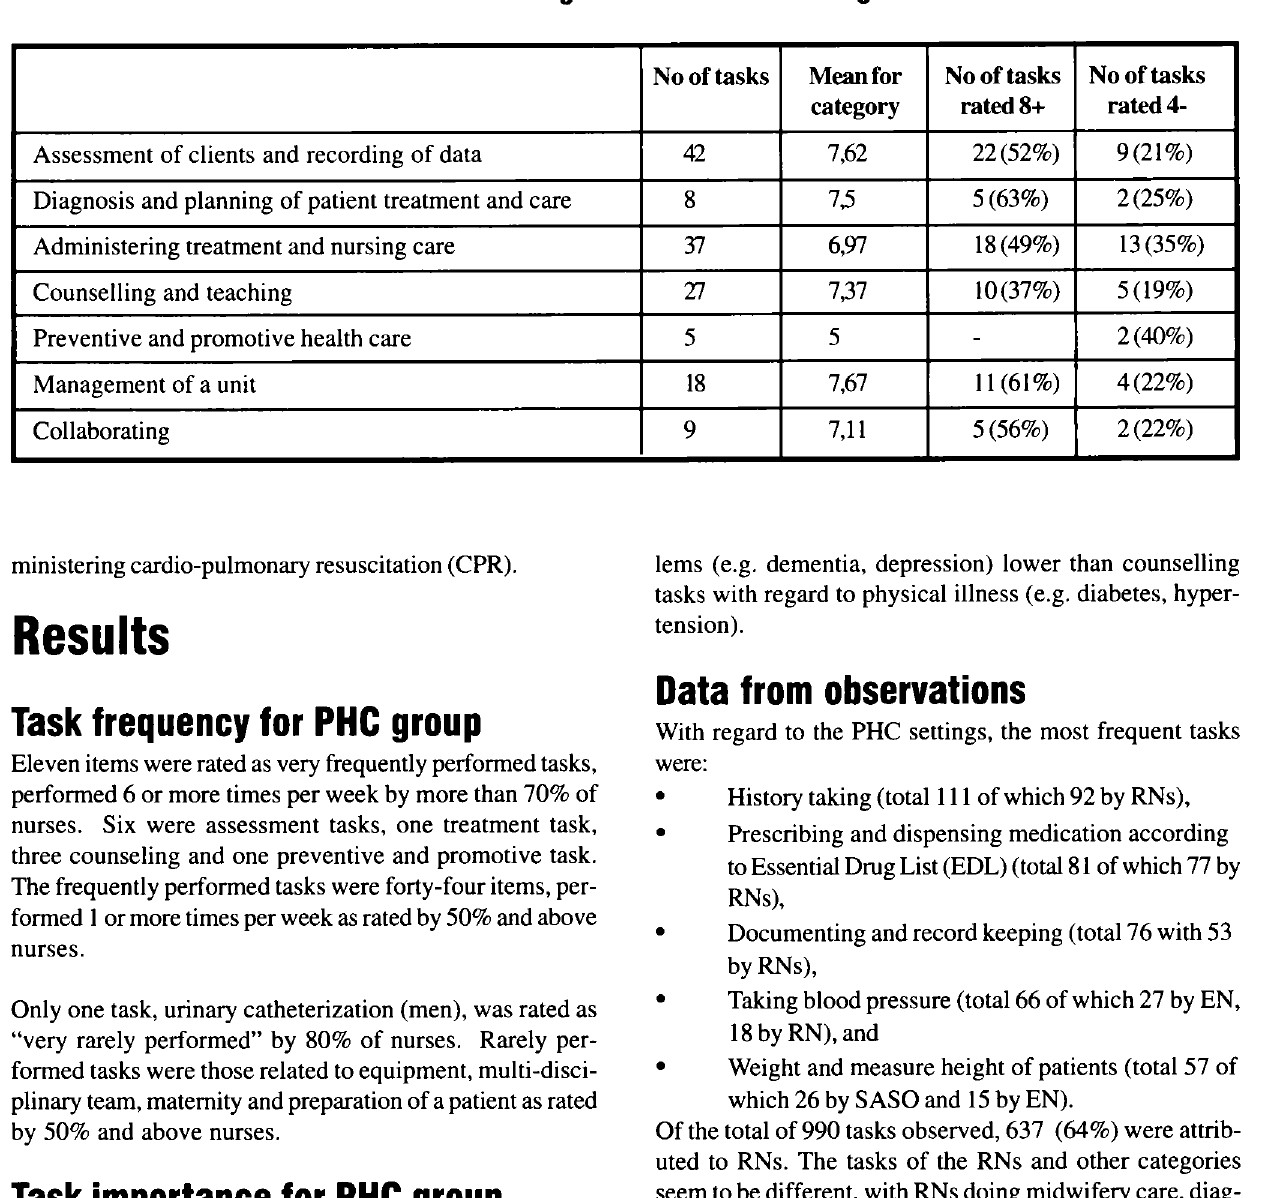
Table 2.3 Task index for PHC nurses with regard to seven task